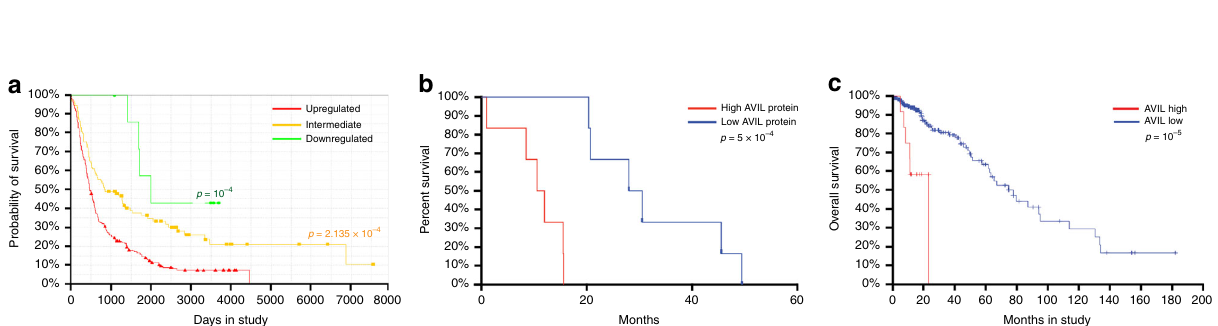
Fig. 2 High AVIL expression is correlated with worse clinical prognosis of glioma patients. a Clinical analysis using the REMBRANDT dataset. A three- class model, strati fi ed by AVIL RNA expression in 343 glioma cases. Higher expression of AVIL correlates with worse overall patient survival ( p = 1 × 10 − 4 , two-sided log-rank test). b A two-class model strati fi ed by AVIL protein expression in the 14 GBM samples. The high AVIL group has worse overall